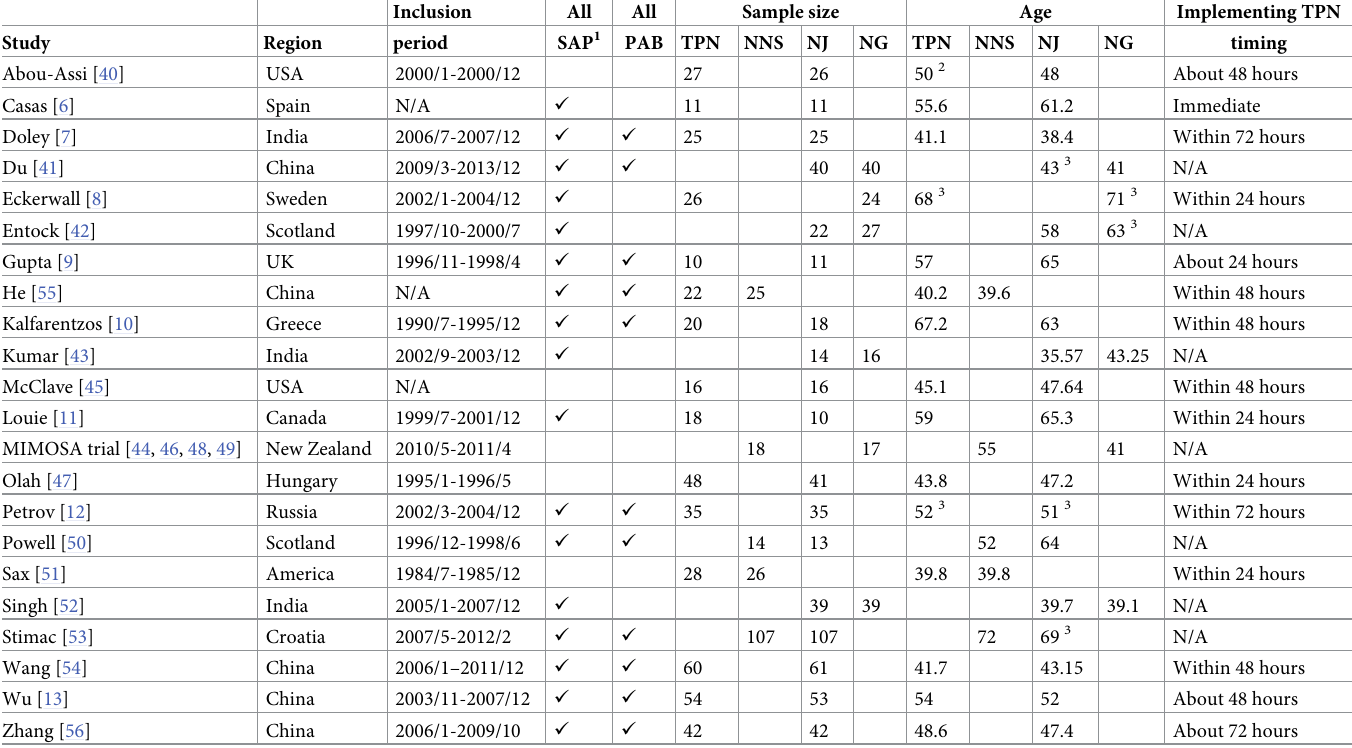
Table 1. Characteristics of the included randomized controlled